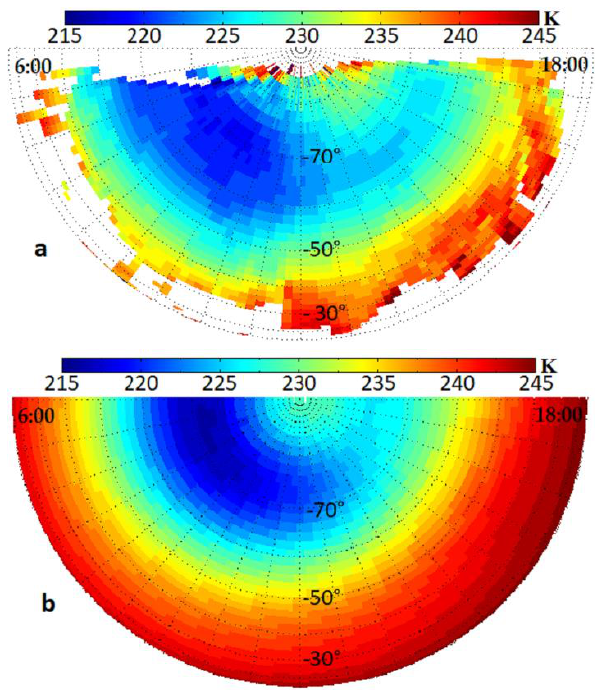
Figure 4. Nighttime polar temperature field (K) at 7 × 10 3 Pa for ( a ) VIRTIS-M and ( b ) the IPSL Venus GCM simulation.